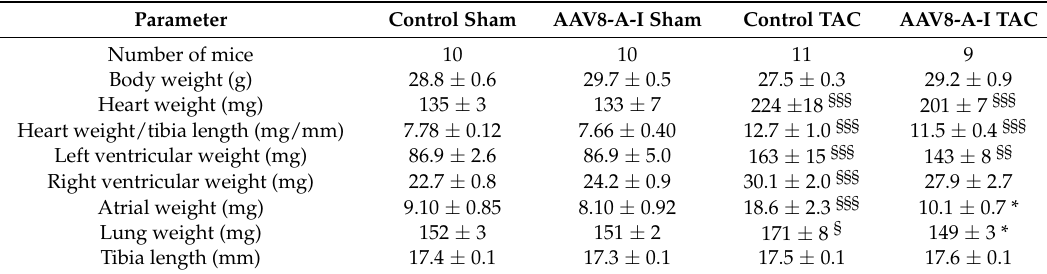
Table 2. Body weight and organ weights in C57BL/6 LDLr − / − mice.